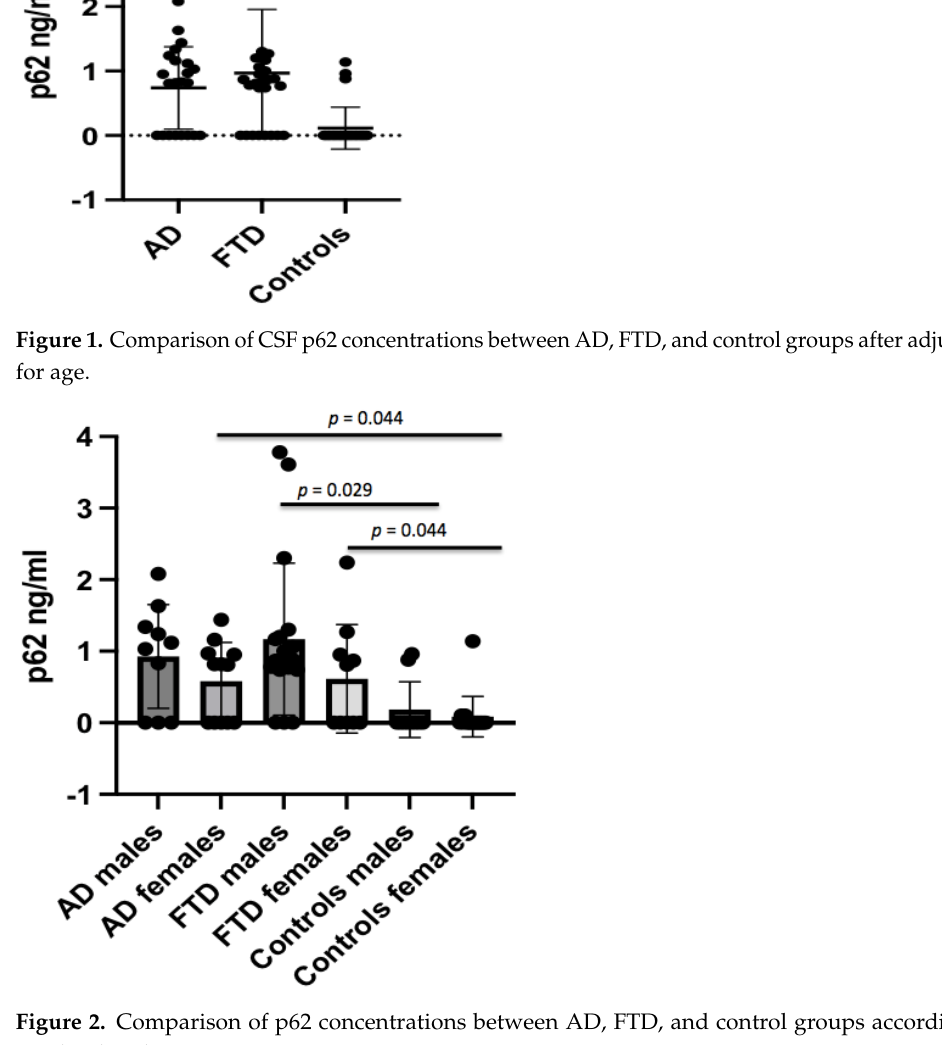
Figure 3. Correlation between CSF p62 and p-Tau and t-Tau concentrations in female FTD patients. 3.4. P62 and Clinical Characteristics Several clinical features emerged as significantly linked to CSF p62 concentrations in the AD group. In AD patients, p62 levels were negatively associated and with the presence 0.0